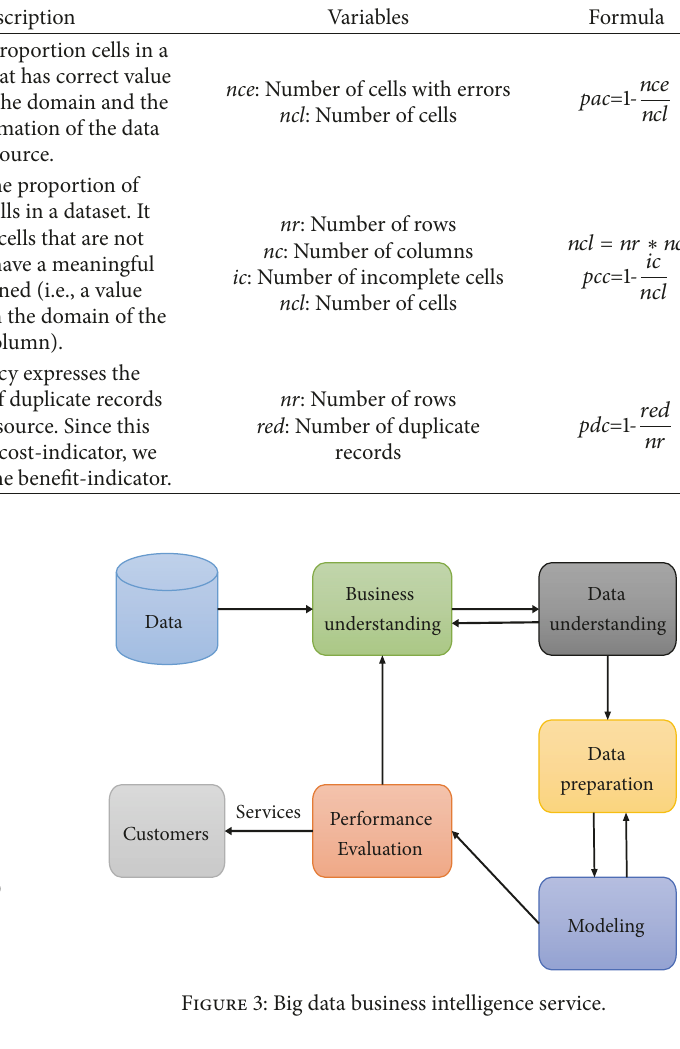
Table 1: Metric definitions, description, and calculation.